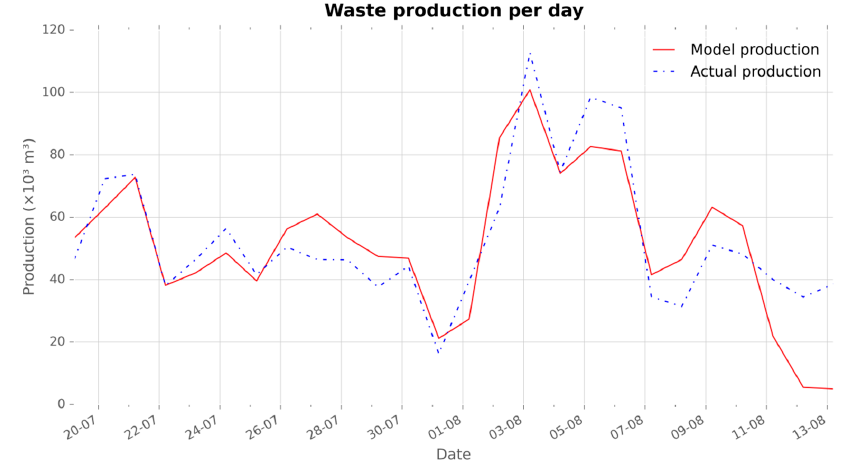
Figure 13 . Comparison of daily production of waste, Experiment 1. Figure 13. Comparison of daily production of waste, Experiment 1.